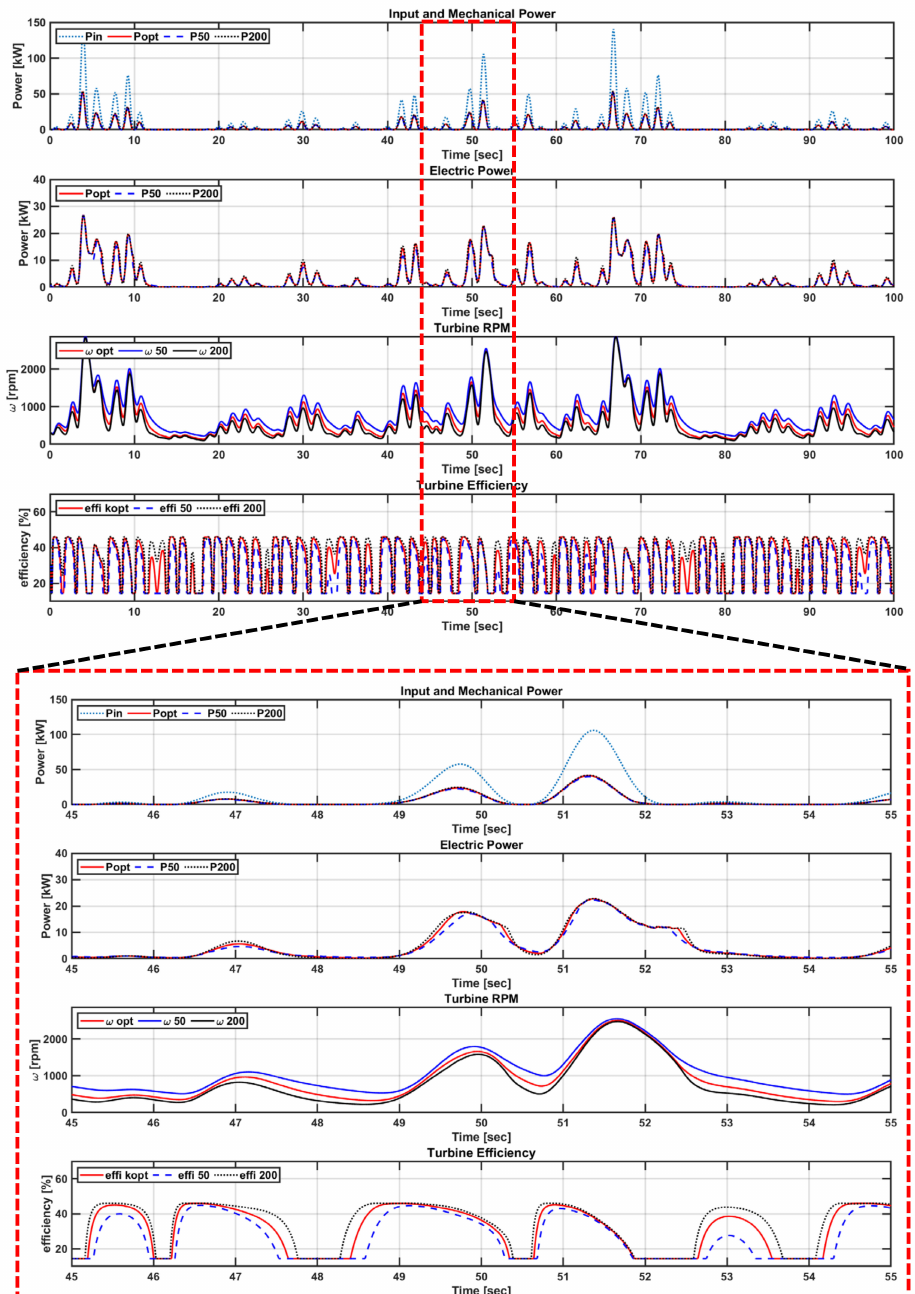
Figure 28. PTO system results in integrated simulation according to the torque factor of diode converter under irregular wave ( v t = 0~42 m / s and Tp = 4.75 s) conditions: Input instantaneous power generation, mechanical instantaneous power generation, electrical instantaneous power generation, turbine rpm, and e ffi